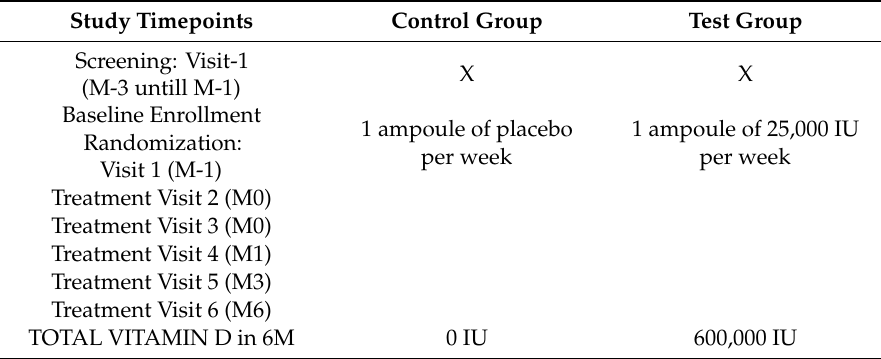
Table 1. Vitamin D / placebo